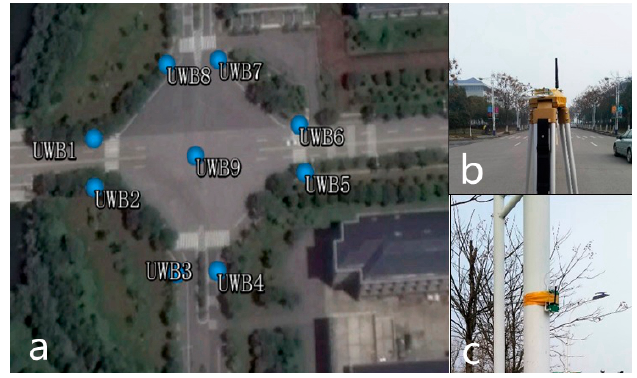
Figure 6. ( a ) Deployment of UWB anchors at the intersection: ( b) centre anchor and ( c) roadside anchor.